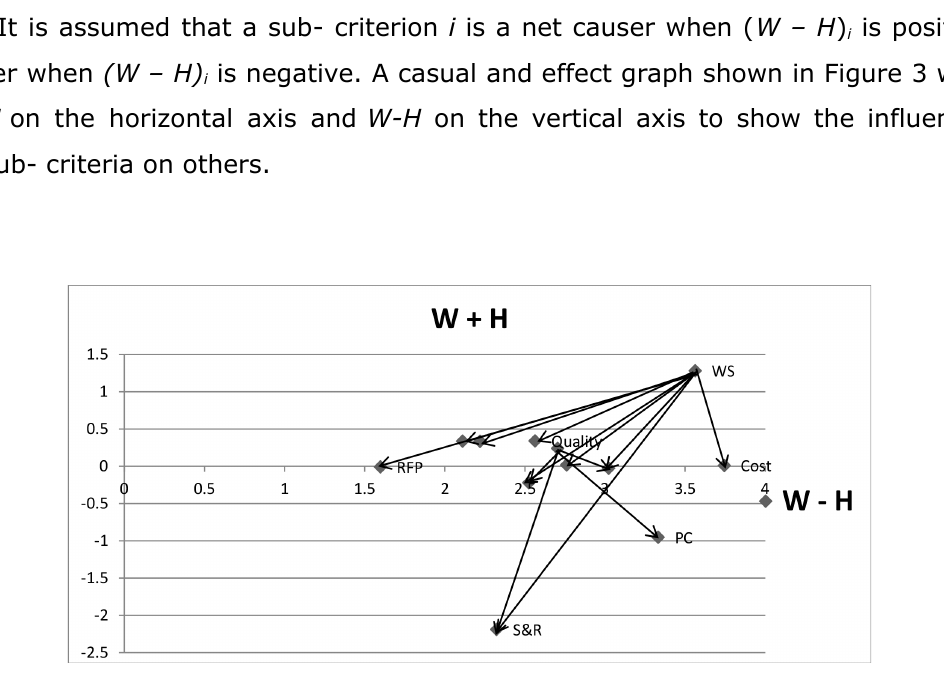
Figure 3. A casual and effect graph of sub- criteria for sustainable Supplier Selection in the company under